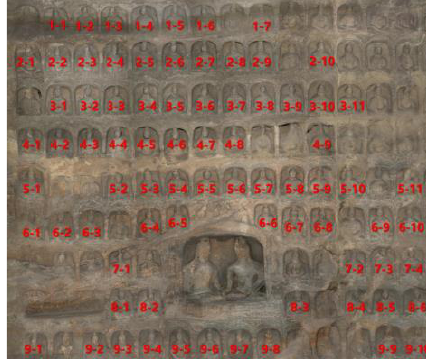
Figure 10. Schematic diagram of niche for Buddha numbering